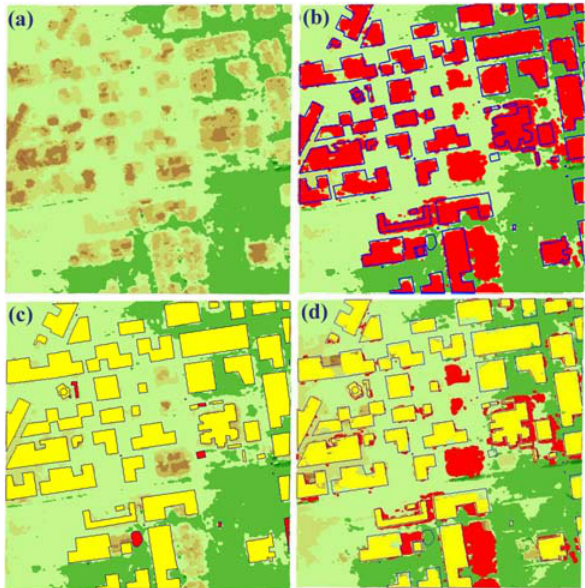
Figure 8. (a) IKONOS DSM of the whole scene, (b) IKONOS DSM superimposed with height blobs from nDSM in red, (c) GIS objects covered (yellow) and not covered (red) by height blobs, the latter being candidates for demolished buildings, (d) blobs (red) not covered by GIS objects, being candidates for new buildings.